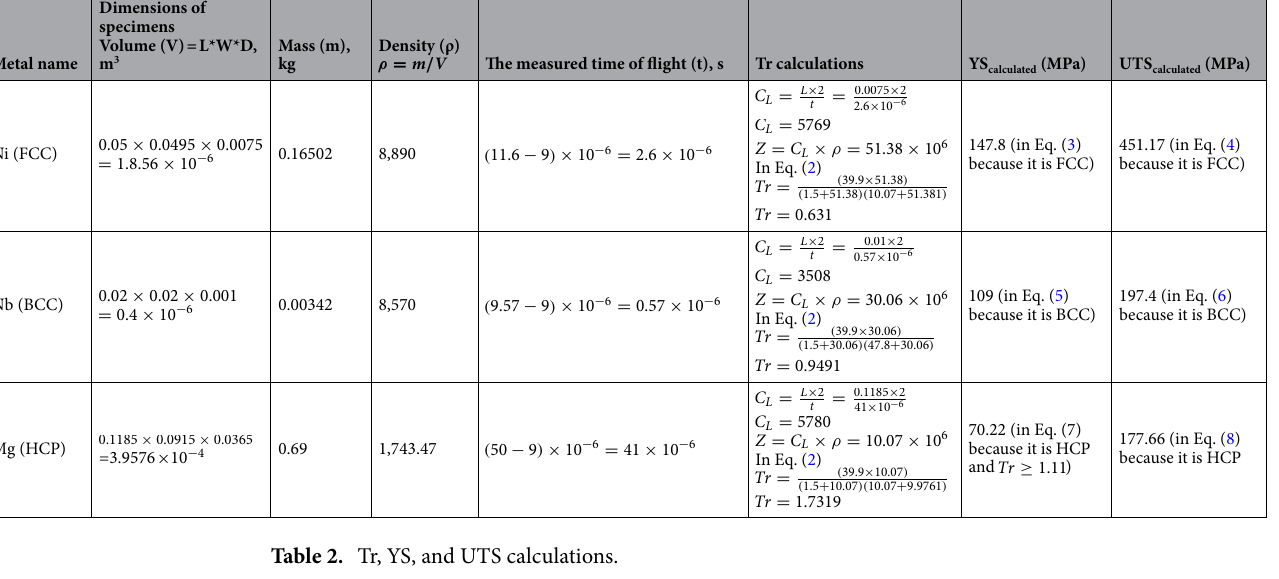
Table 2. Tr, YS, and UTS calculations.